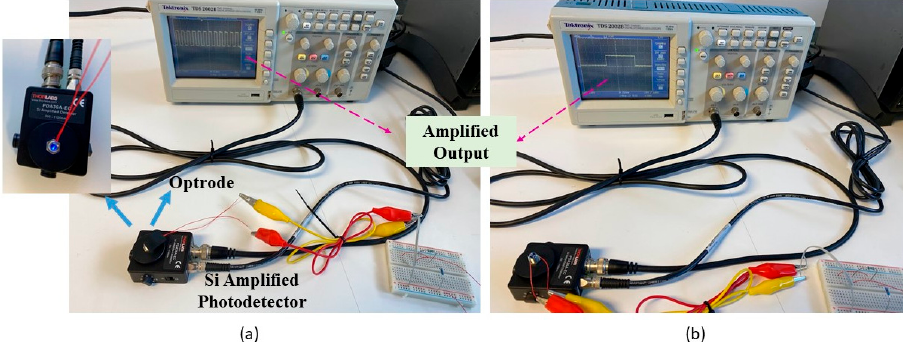
Figure 8. Experimental design for the optical evaluation of the optrode, with the oscilloscope showing the output corresponding to: ( a ) stimulation pulse width of 10 ms, and ( b ) stimulation pulse width of 1000 ms.